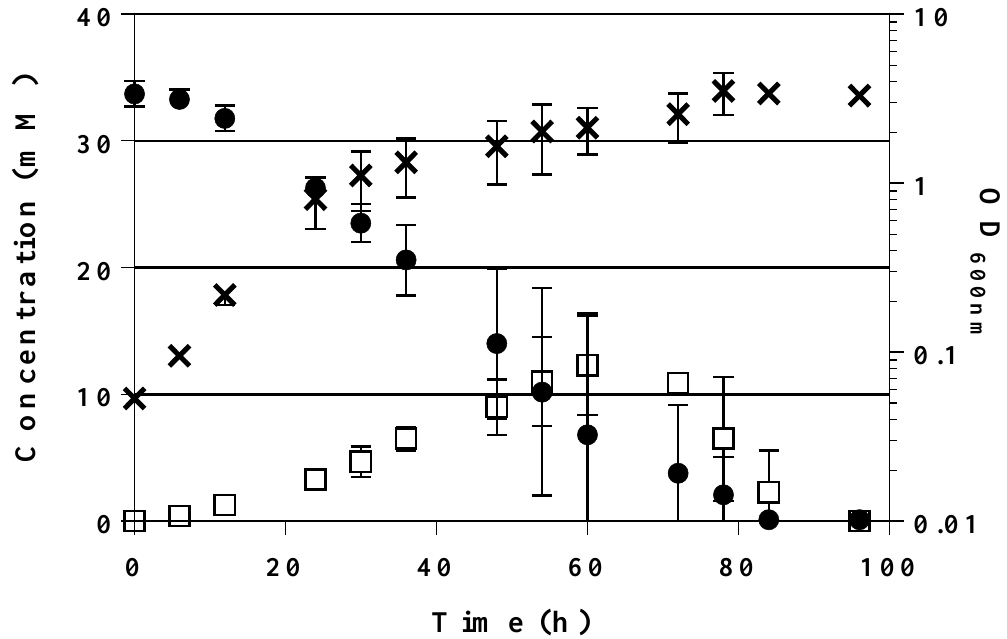
Figure 5. Glucose consumption (●) and DHA accumulation (□) in the culture supernatant of GL3/pJF119 fsaA A129S during growth on MM glucose and 100 µM IPTG over the time course of 96 h. OD 600 nm ( ✖ ). The actual concentrations of glucose and DHA were determined by HPLC. Mean values and standard deviations from two independent biological replicates and two technical replicates each.